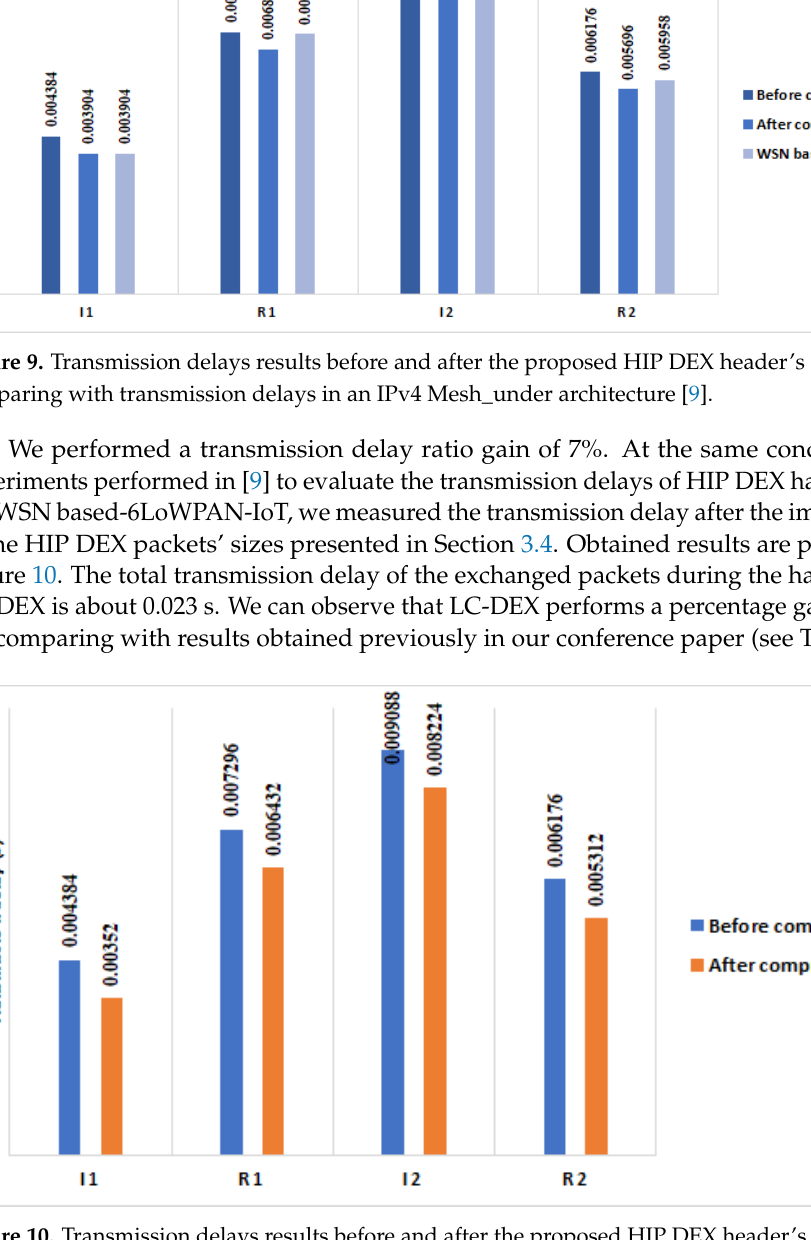
Figure 10. Transmission delays results before and after the proposed HIP DEX header’s compression in LC-DEX solution. Table 7. Comparison of handshake’s transmission delays with [9] after the proposed